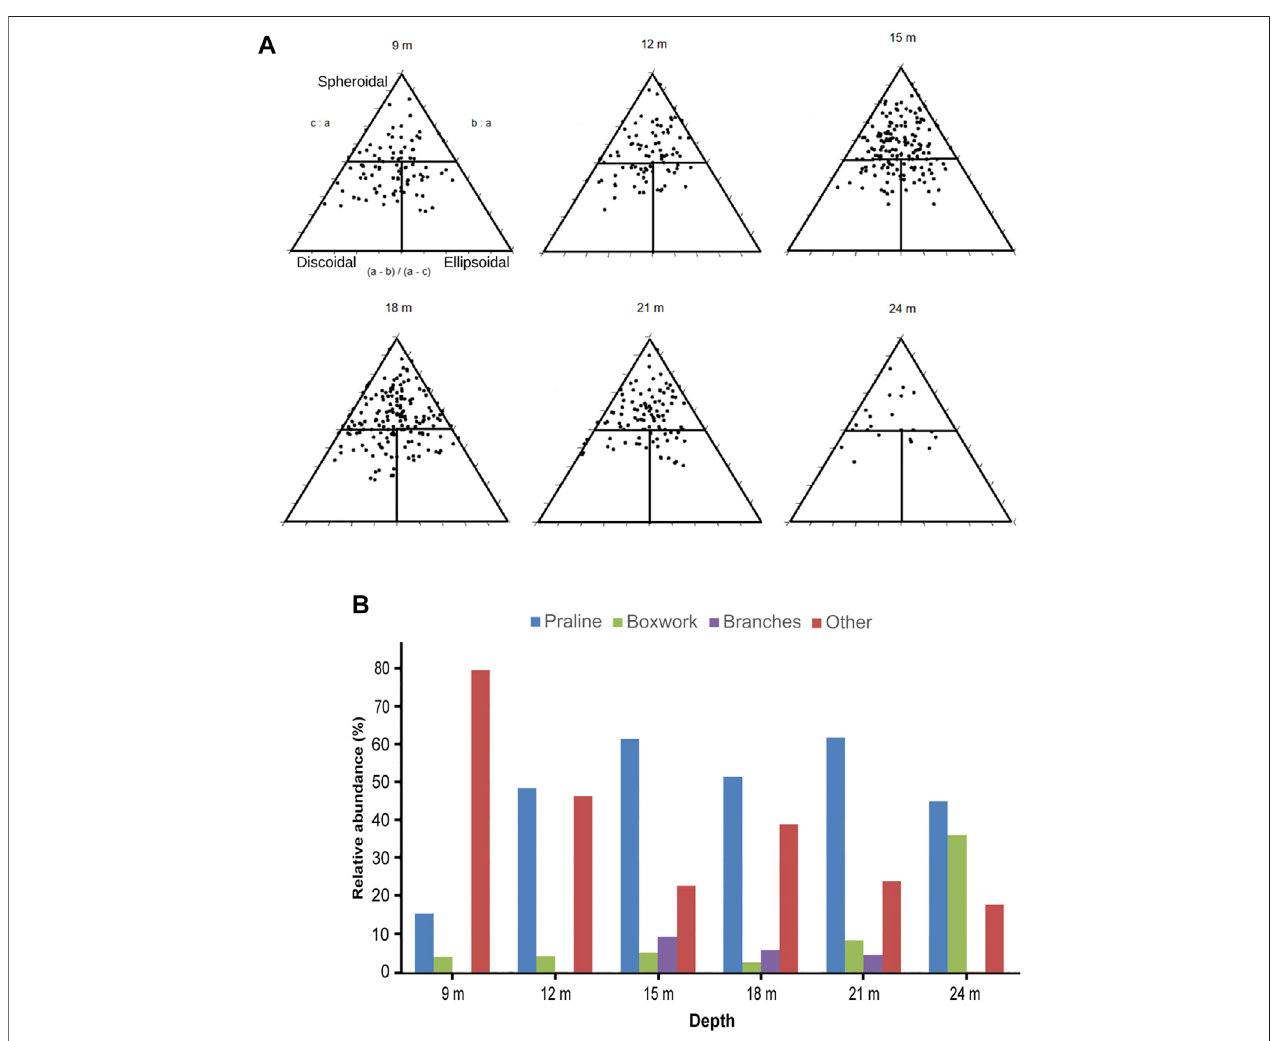
FIGURE 12 | (A) Triangular diagrams of rhodolith shape classes at each sampling depth (Sneed and Folk, 1958; Bosence, 1983; Graham and Midgley, 2000) and (B) relative proportions of rhodolith morphotypes at each sampling depth. Other includes coatings on lithoclasts and bioclasts, and compact rhodoliths of encrusting coralline